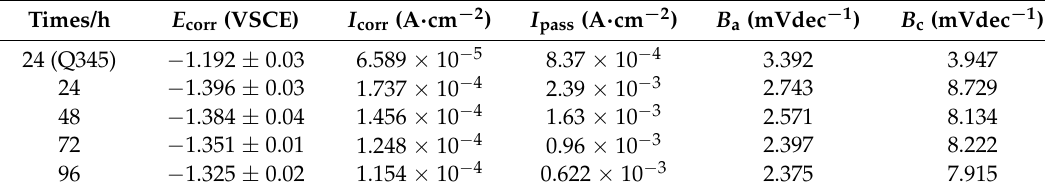
Figure 4. Potentiodynamic polarization curves of the Q345 steel substrate, Zn–Al coating in 3.5 wt.% NaCl solution. Table 2. Fitted parameters of polarization curves for the Q345 after immersion of 24 h and the Zn–Al coatings after immersion of 24, 48, 72 and 96 h in 3.5 wt.% NaCl